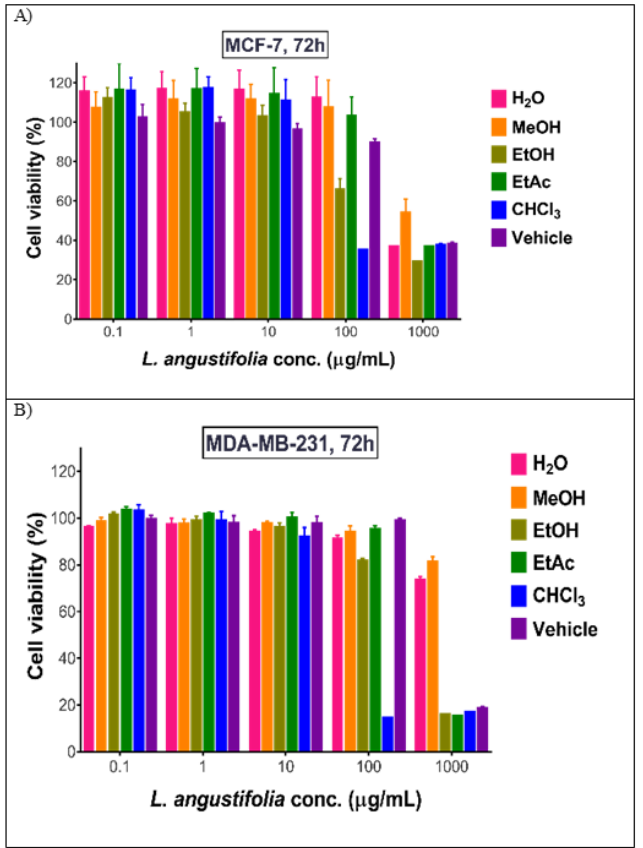
Table 4. IC 50 (µg/mL) for different extracts of L. angustifolia tested on three cell lines (MCF7, MDA- MB-231, and Fibroblast).